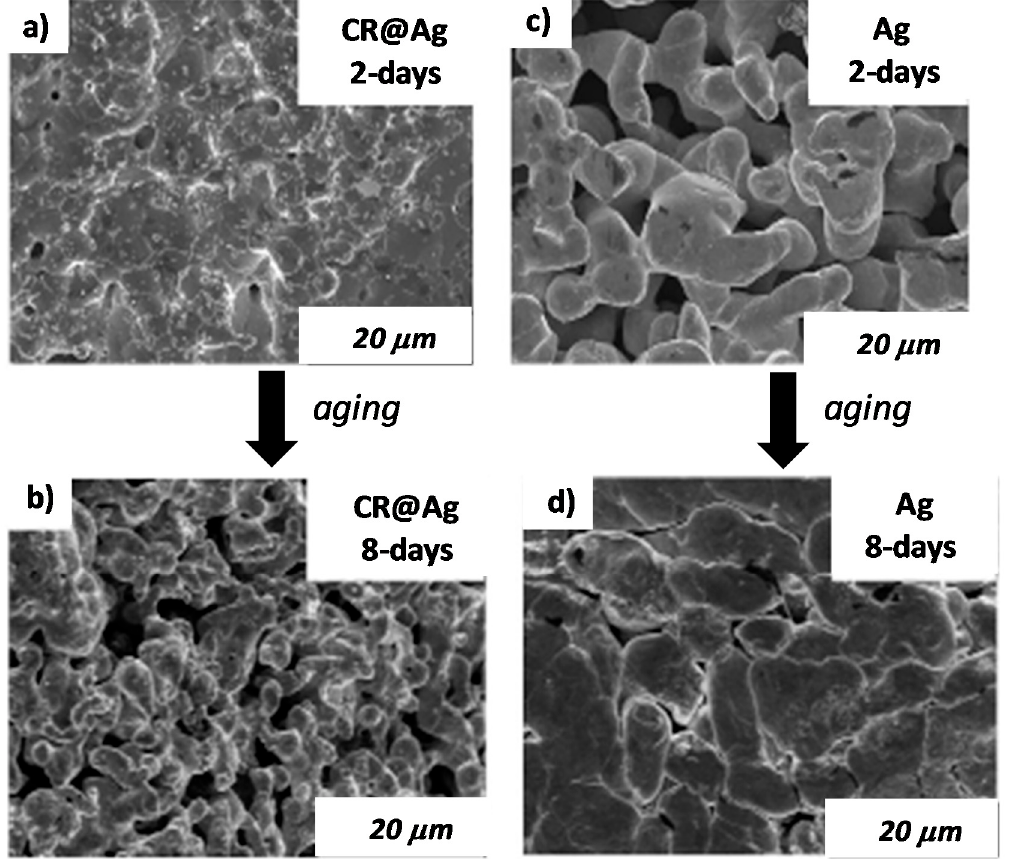
Figure 1. The morphology of CR@Ag ( a , b ) and of Ag ( c , d ) after the catalytic procedure: ( a , c ) 2-days catalyst synthesis time; ( b , d ) 8-days. [Reprinted from Ref. [24], copyright (2011) with kind permission from Royal Society of Chemistry, permission conveyed through Copyright Clearance Center, Inc.].